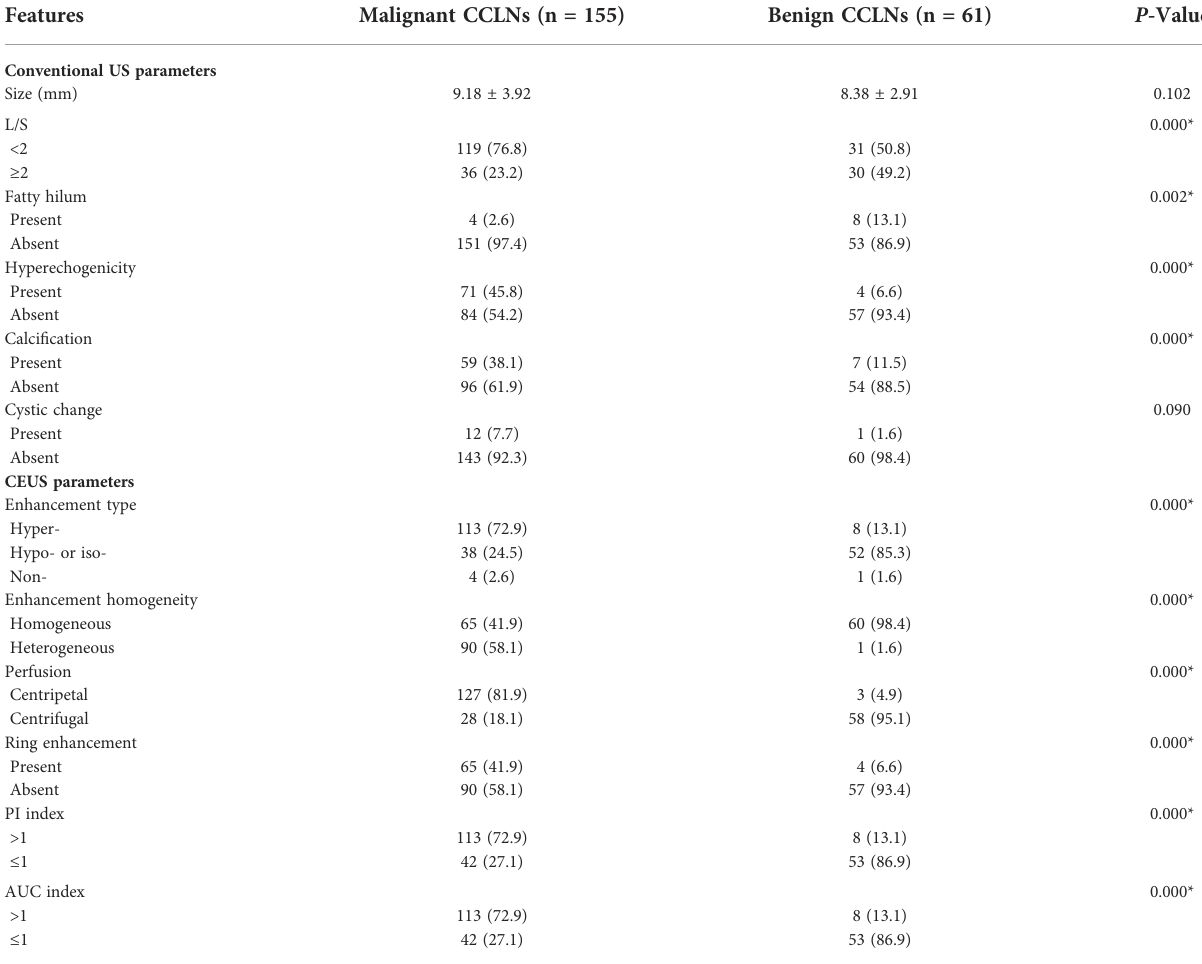
TABLE 2 Ultrasonographic features of the malignant and benign CCLNs in patients with